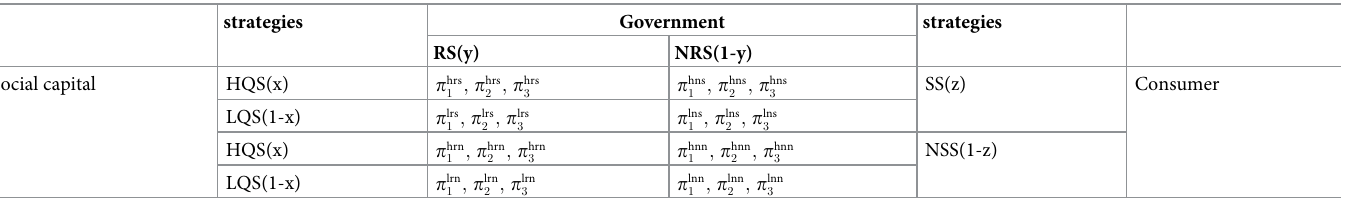
Table 2. Tripartite evolutionary game payoff